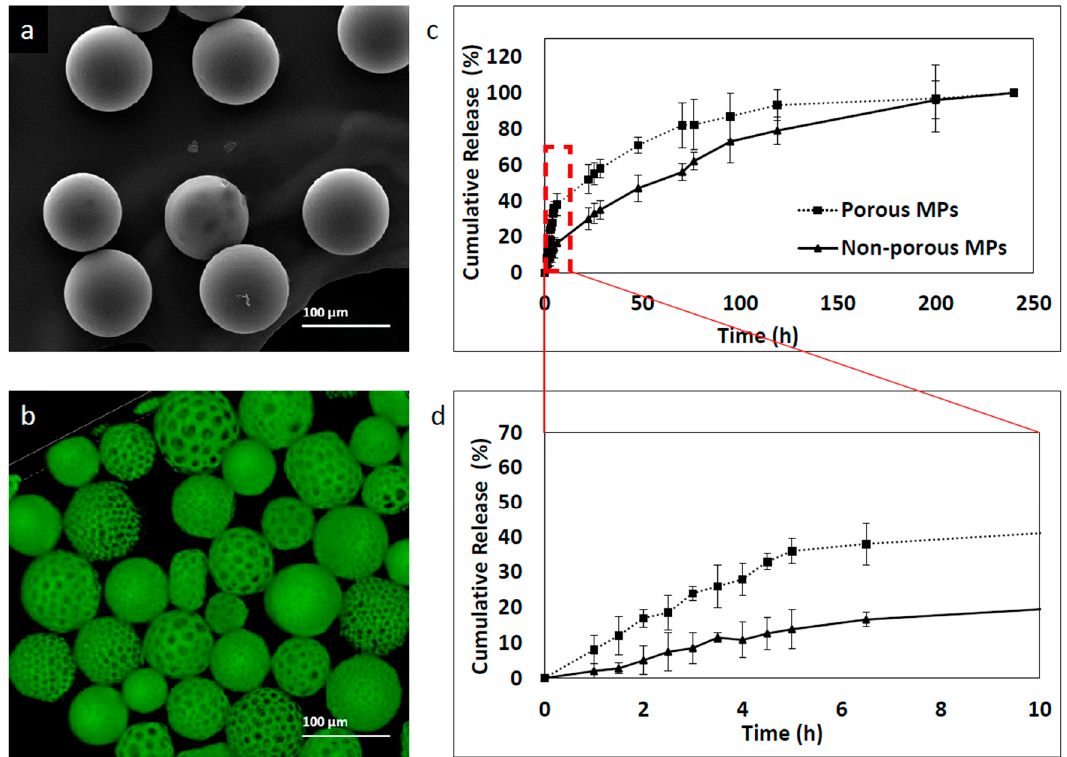
Figure 8. 6-coumarin release kinetic profile of MPs fabricated with the microfluidic approach. Samples were collected at a number of points of time and fluorescence was measured by a plate reader. Empty particles were used as control references. ( a ) Non-porous MPs, ( b ) porous MPs, ( c ) cumulative release profile of 250 h and ( d ) cumulative release profile of the initial 10 h.